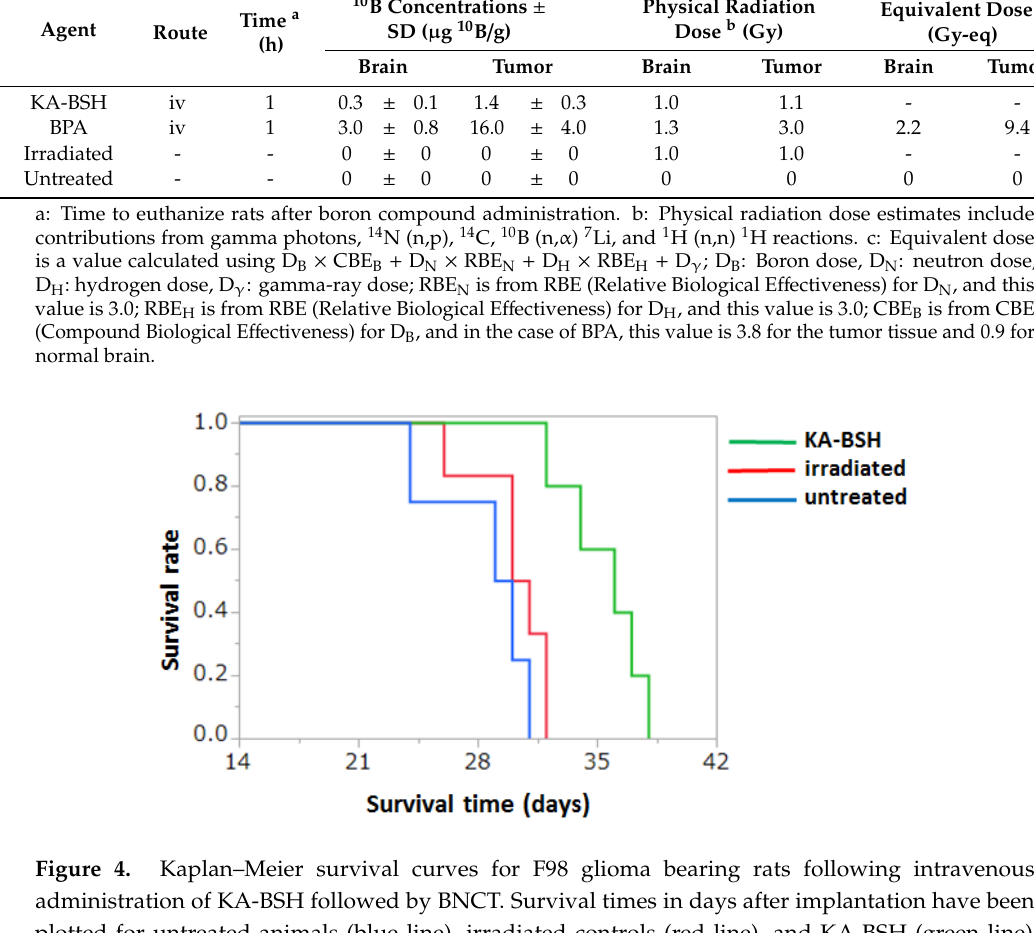
Table 1. Summary of 10 B concentrations, physical radiation doses, and biological radiation doses delivered in F98 glioma bearing rats.